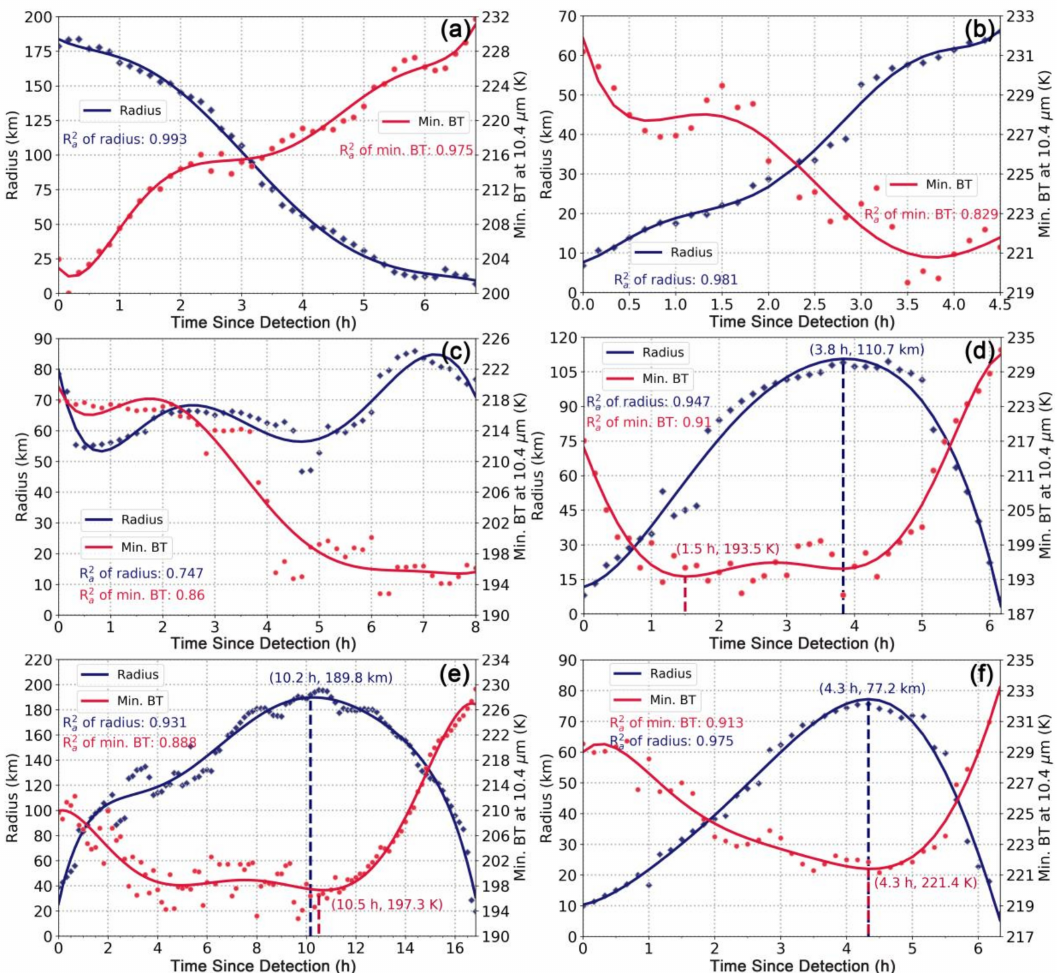
Figure 4. Temporal evolution of minimum BT and equivalent radius (R e ) of six di ff erent types of MCS during their normalized lifetime: ( a ) MCSs with a large size when they are first detected, followed by continuously shrinking sizes and decreasing cloud tops; ( b ) MCSs with small size when they are first detected, followed by continuously enlarging sizes and rising cloud tops; ( c ) MCSs with sizes that do not change much during their lifetime except for the rising cloud tops. ( d )–( f ) denote the MCSs with entire lifecycles, di ff ering by the time when the minimum BT occurs being ahead of ( d ), being lag behind ( e ), and at the same time as the time when the maximum R e occurs ( f ). Additionally, R 2 a refers to the coe ffi cient of determination, measuring the goodness of fit of the sixth-order polynomial